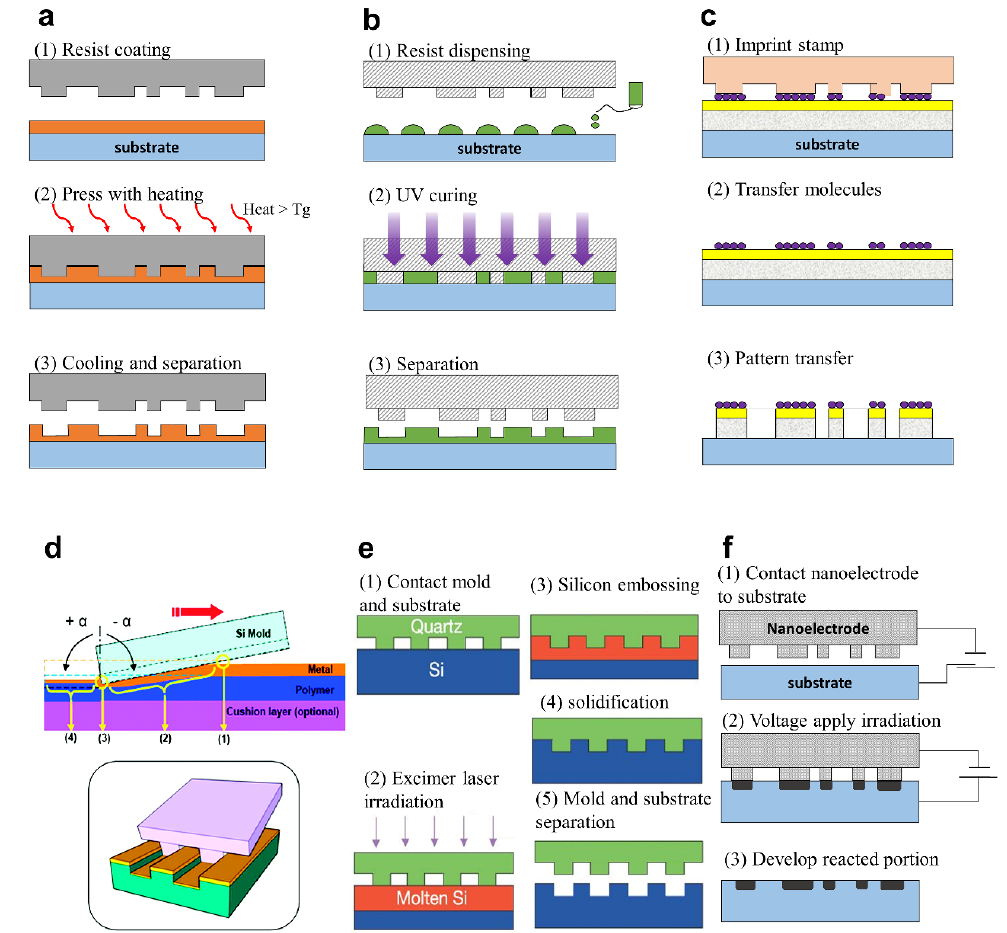
Figure 6. Schematics of various NIL processes: ( a ) Thermal NIL, ( b ) UV NIL. ( c ) Soft lithography. ( d ) Dynamic nanoinscribing (DNI): (1) initial contacting point, (2) gradual imprinting region, (3) edge point responsible for plastic deformation, and (4) elastic recovery region [136]. ( e ) Laser-assisted direct imprint (LADI). ( f ) Nanoelectrode lithography (NEL) [137]. Reproduced with permission from ( d ) [136]; American Chemical Society, 2009, and ( f ) [137]; American Vaccum Society, 2003.